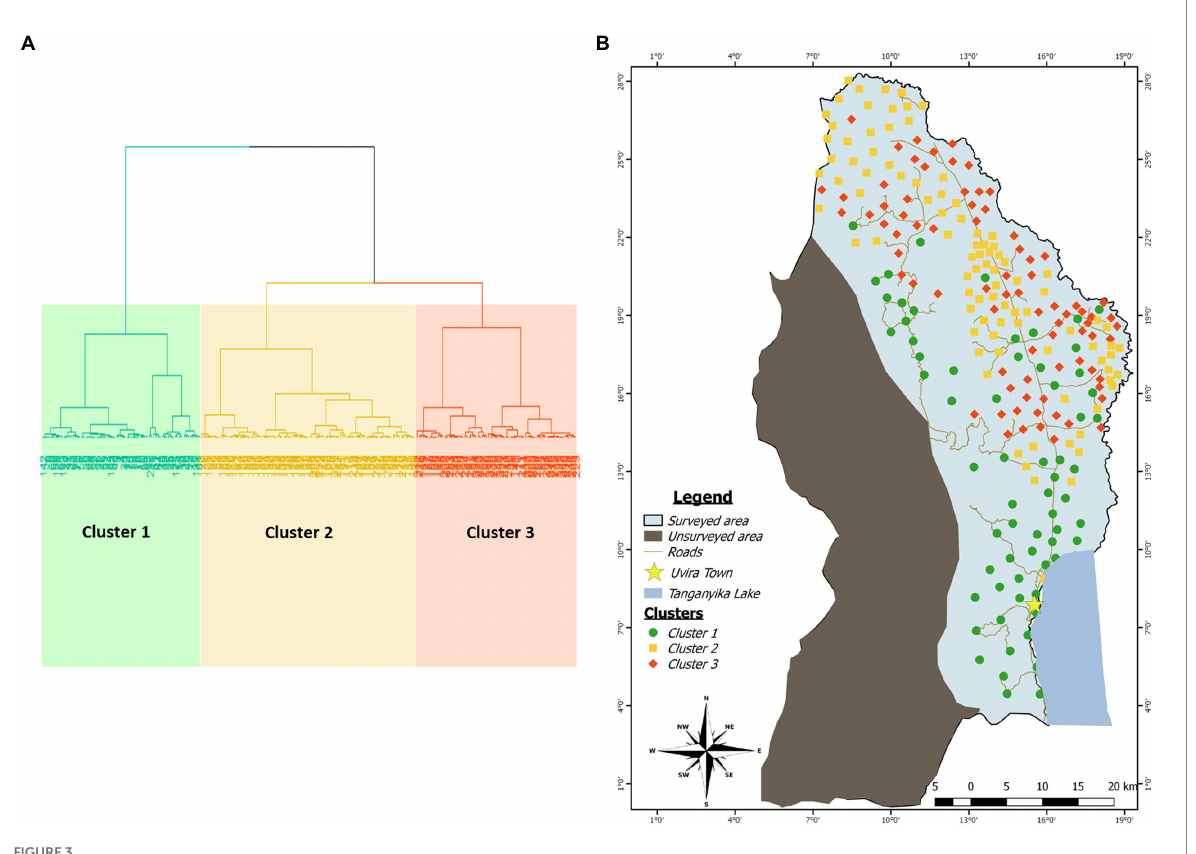
FIGURE 3 (A) Cluster dendogram showing the repartition of the data into three clusters using the Hierarchical Clustering on Principal Component method. (B) Mapping of the clusters identified by HCPC in the study area. Each color category is associated to a cluster: Green for cluster 1, yellow for cluster 2 and red for cluster